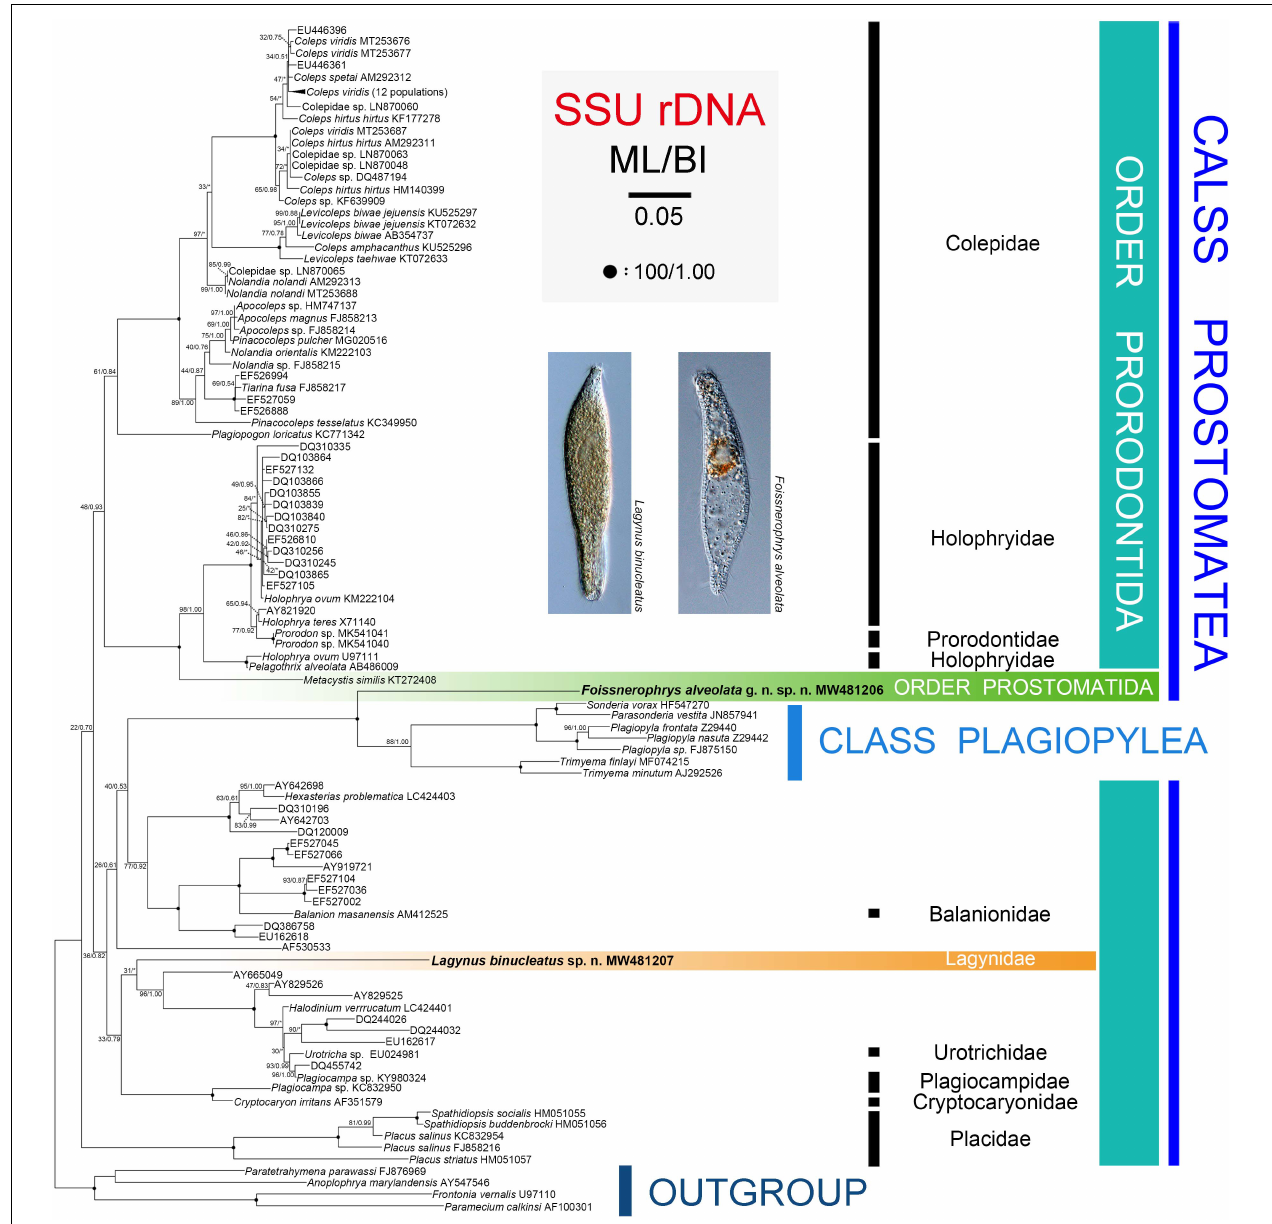
FIGURE 6 | Maximum likelihood (ML) tree inferred from SSU rRNA gene sequences with nodal support for ML and BI analyses. Newly sequenced species, i.e., Lagynus binucleatus sp. n. and Foissnerophrys alveolata gen. n., sp. n., are in bold. Numbers near nodes denote maximum likelihood (ML) bootstrap values and Bayesian inference (BI) posterior probabilities, respectively. Asterisks (*) reflect disagreements in topology between the BI and ML trees. The scale bar corresponds to 0.05 expected substitutions per site.